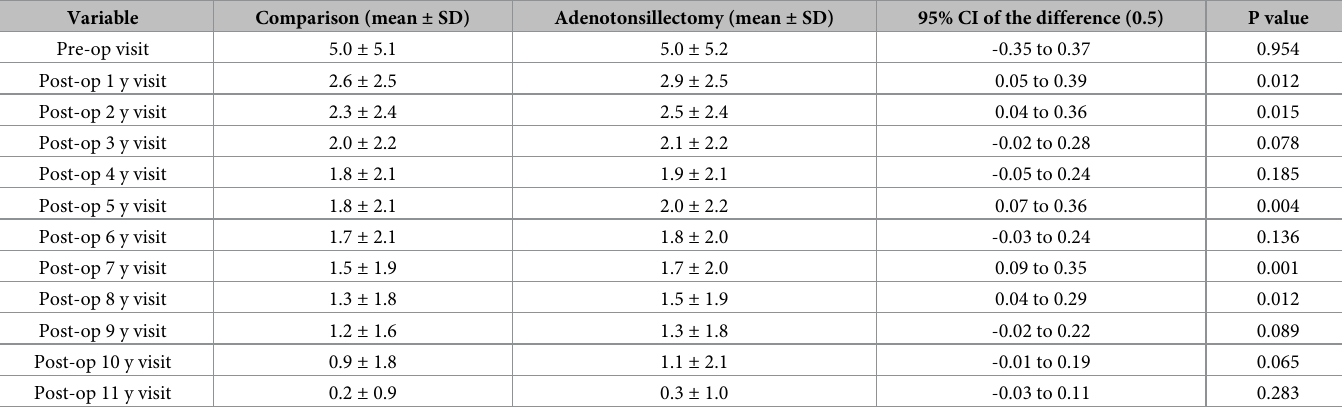
Table 5. Comparison of equivalence test for upper respiratory infections in the pre- and post-operative